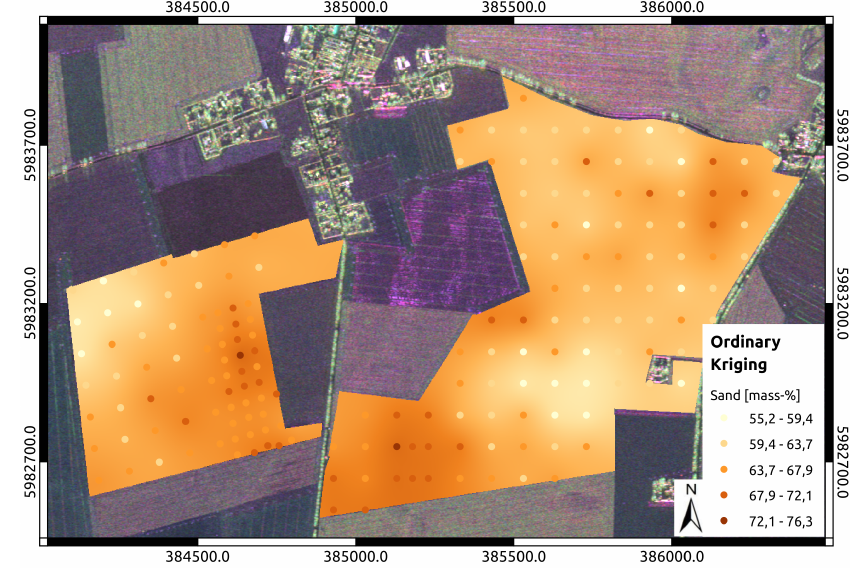
Figure 11. Spatial interpolated soil map for the texture class sand based on the Ordinary Kriging (OK) approach. Circles display the sample locations and colors are scaled in the same color as background sand map.